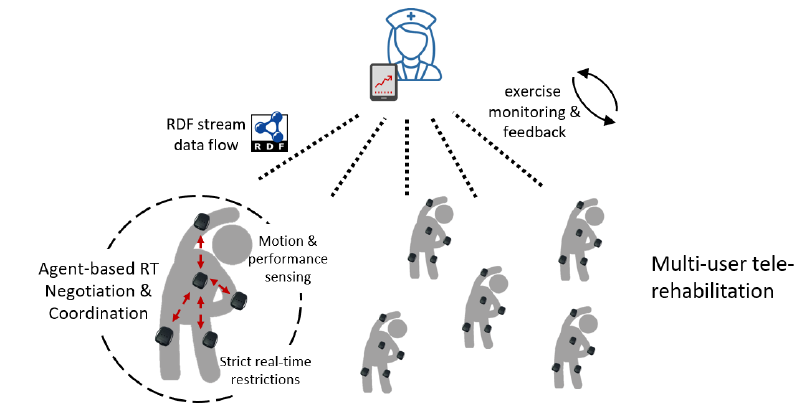
Figure 2. Digital rehabilitation scenario with multiple patients: decentralized and autonomous stream data management for heterogeneous sensors. Expanding from the previous scenario, real-time stream processing agents coordinate to provide per-user monitoring and feedback, while RDF streams are used for semantically-aware data exchange within a group of patients. The healthcare professional can then monitor and provide personalized feedback according to individual